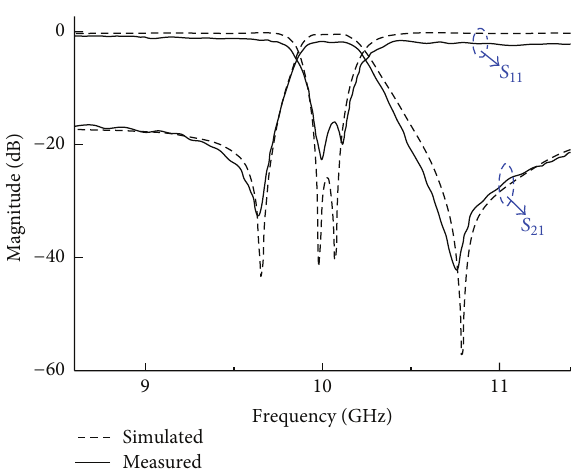
Figure 8: Simulated and measured results of the fabricated